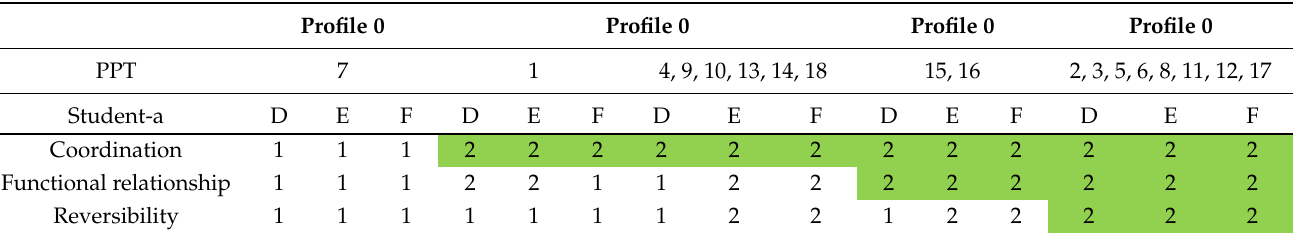
Table 8. Levels obtained by PPTs sorted by profiles.